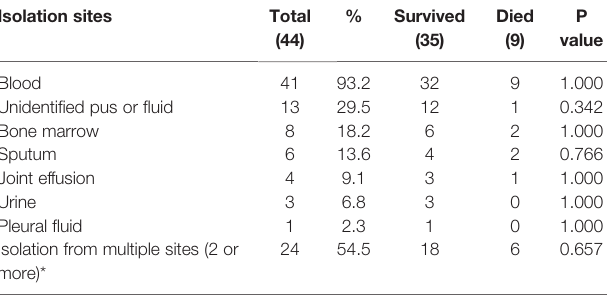
TABLE 2 | The isolation sites of 44 Burkholderia pseudomallei isolates collected from melioidosis patients with osteomyelitis and septic arthritis. Isolation